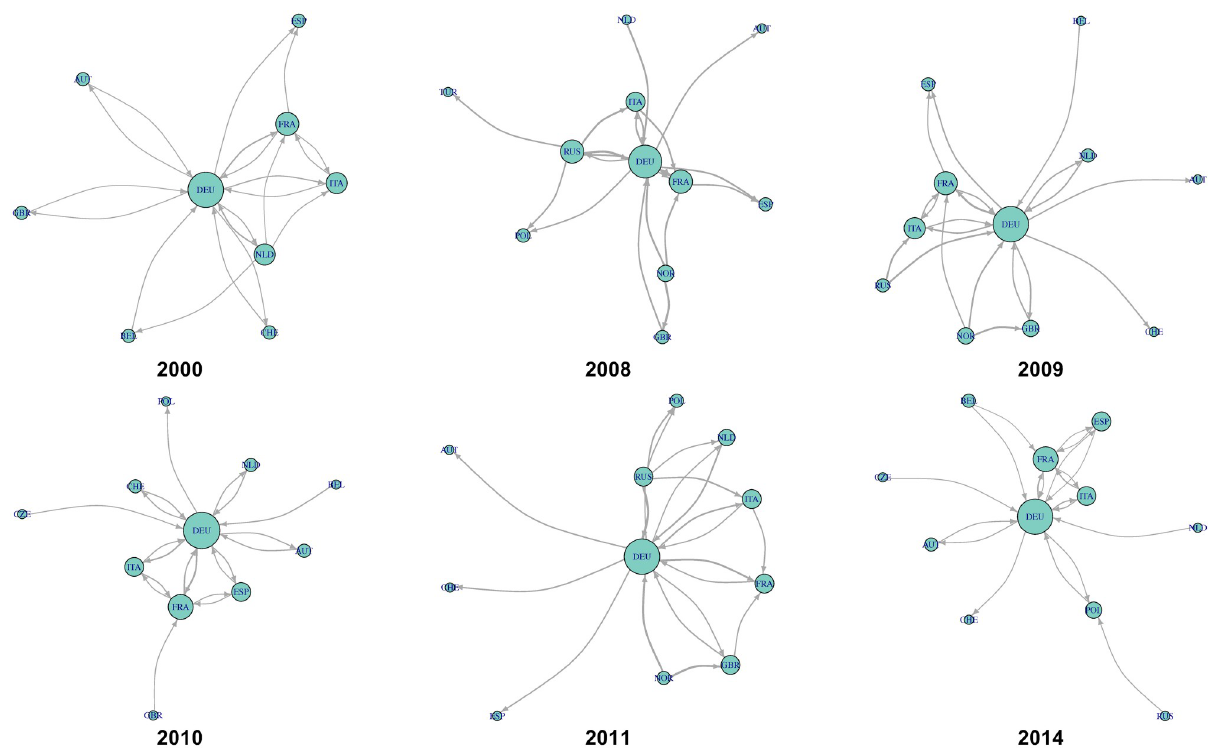
Fig 12. International value-added circulation of European community in 2000, 2008–2011, and 2014. These graphs illustrate the top 20 links. Their node sizes and link widths are in proportion to the square root of the degree and the amount of circular flow, respectively. S1 Table shows a detailed list of the